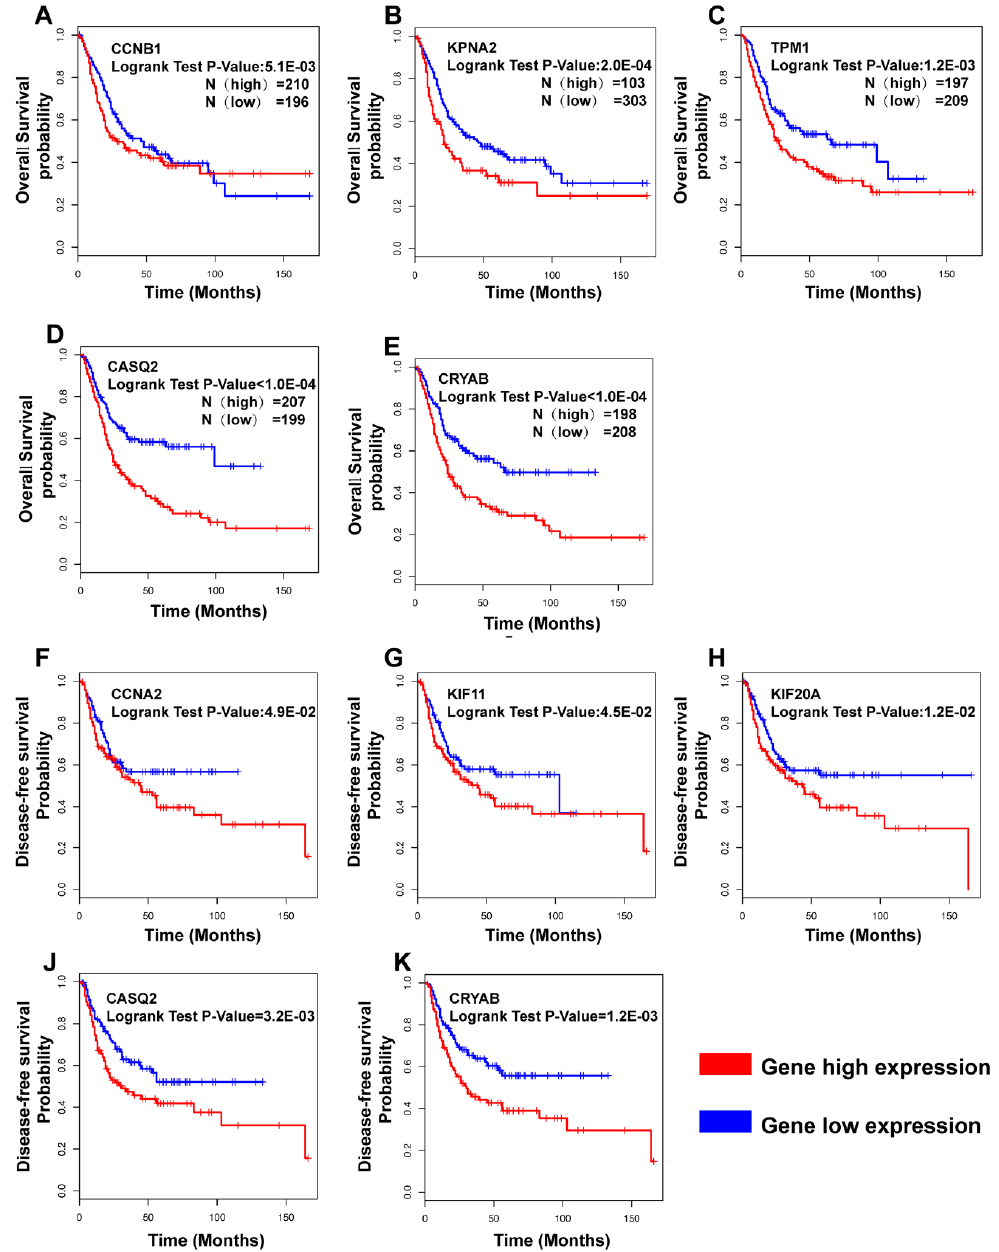
Figure 7. Overall survival and disease-free survival analyses of hub genes. Regarding the 14 hub genes analyzed, ( A – E ) show the significant results of OS; ( F – K ) show the significant results of DFS analysis. In DFS analysis, the cutoff—high and the cutoff—low each account for 50%. With GEPIA (http: // gepia.cancer-pku.cn, accessed on 11 November 2019) using data from